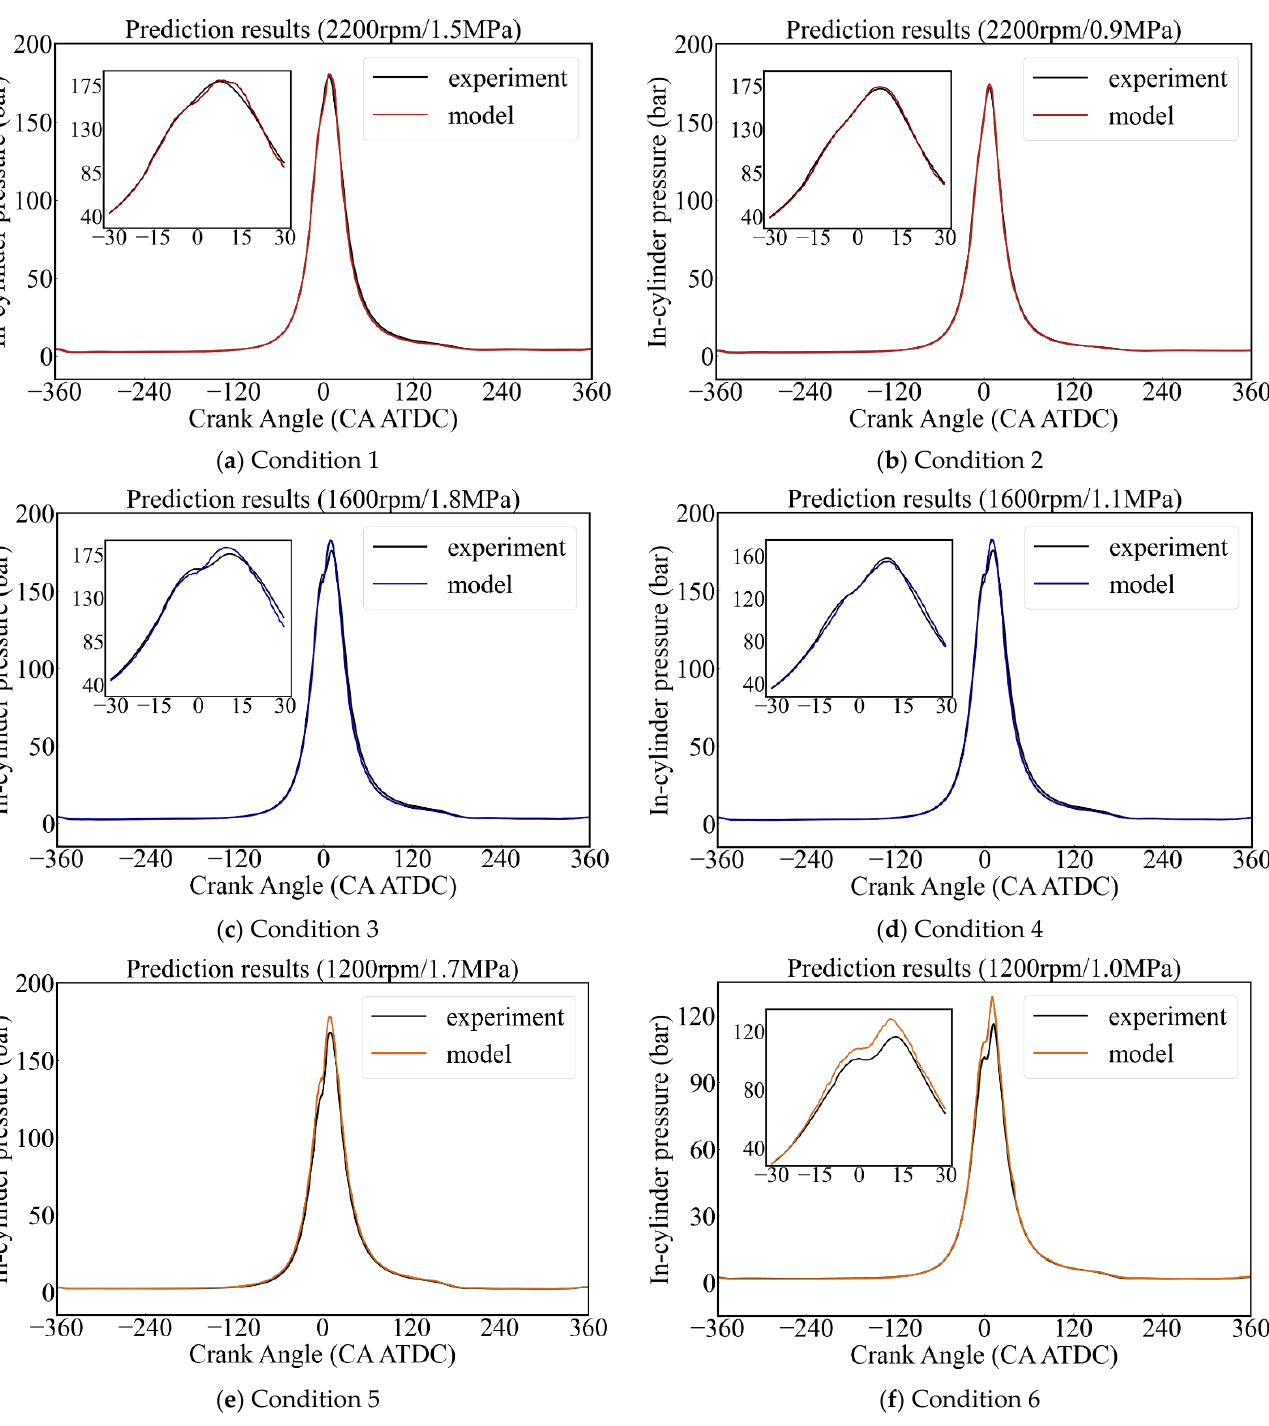
Figure 10. Comparison between predicted value and actual value of in-cylinder pressure in valida- tion conditions.